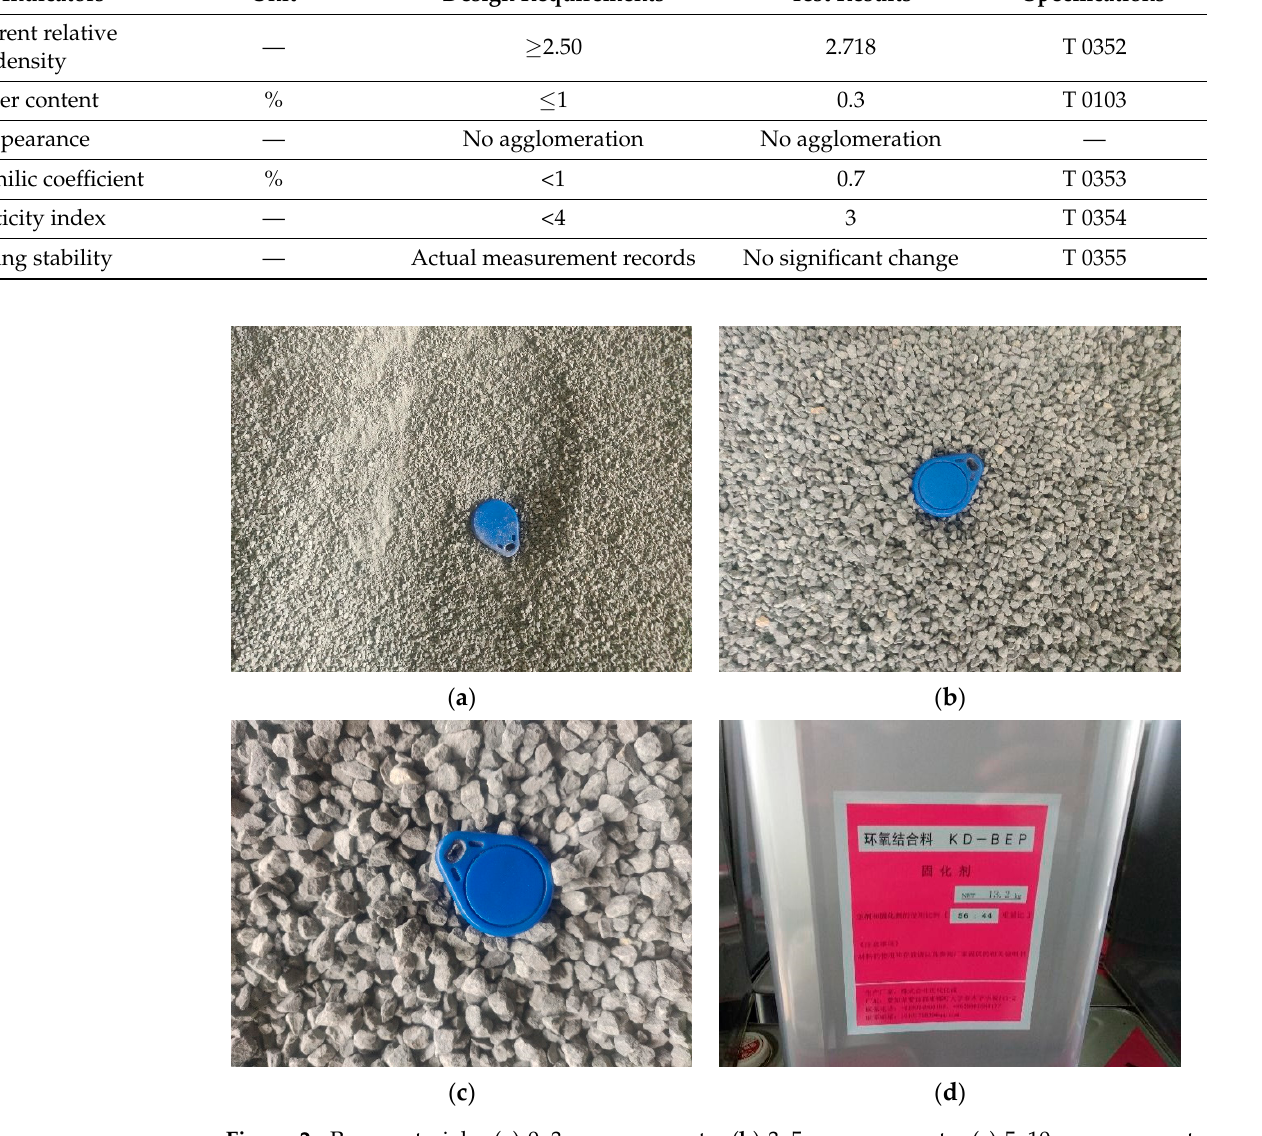
Figure 2. Raw materials: ( a ) 0–3 mm aggregate; ( b ) 3–5 mm aggregate; ( c ) 5–10 mm aggregate; ( d ) epoxy